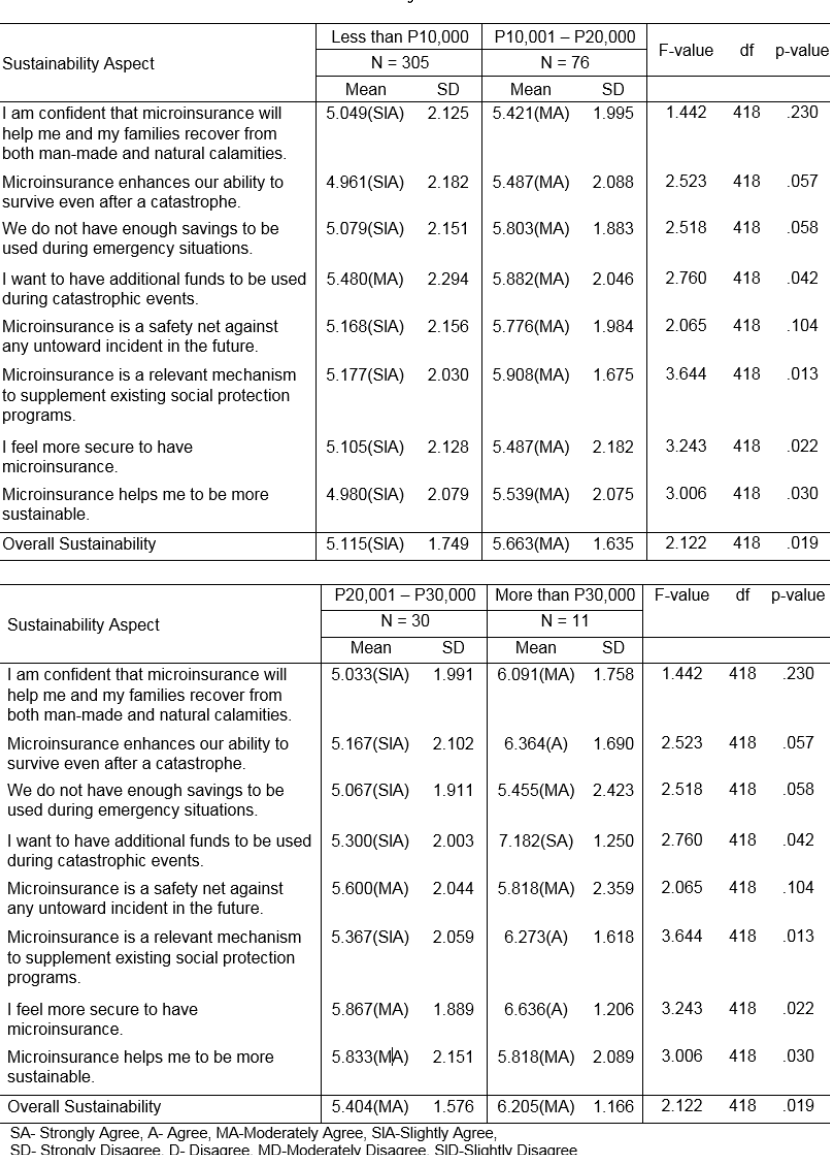
Table 4: Level of Agreement of the Respondents on the Sustainability aspect of Microinsurance When Grouped According to Monthly